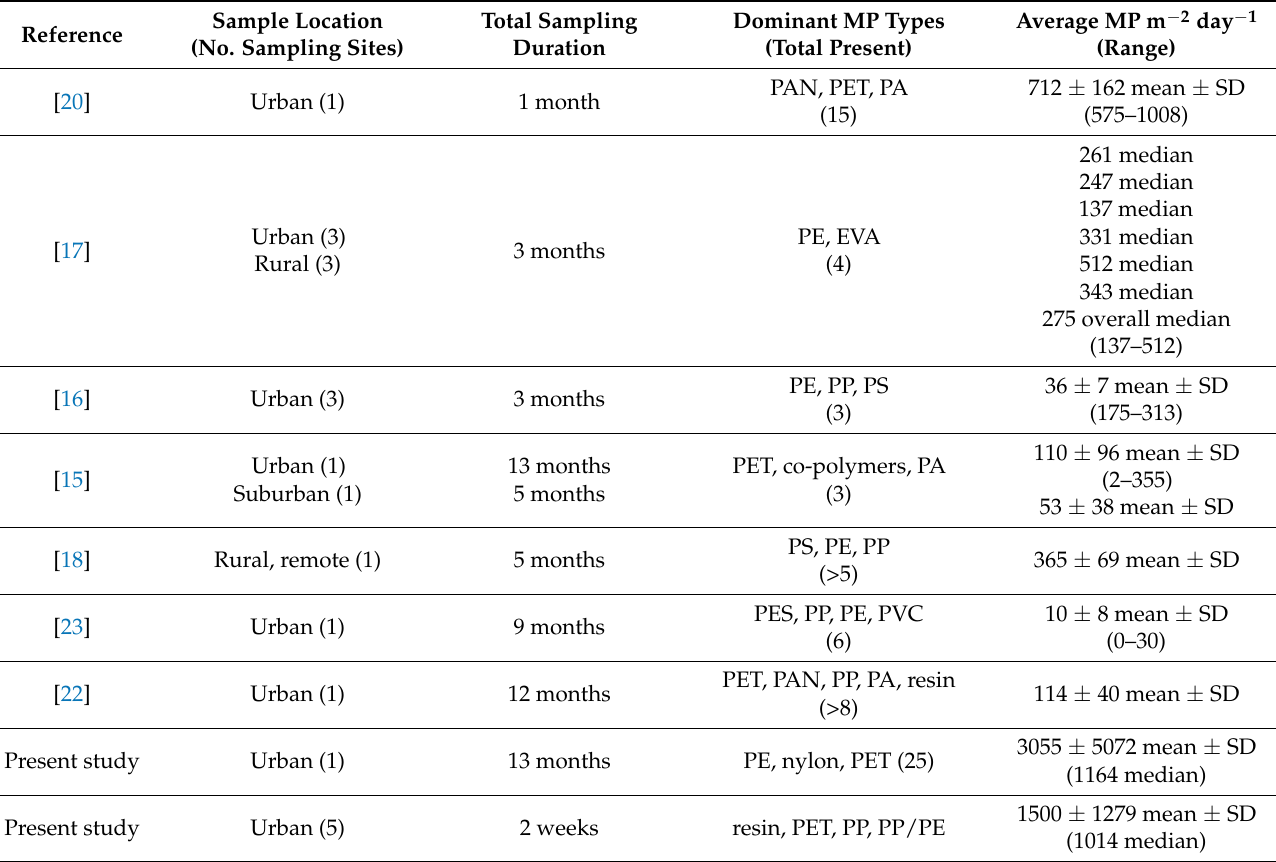
Table 1. Summary of studies reporting outdoor atmospheric microplastic deposited samples.